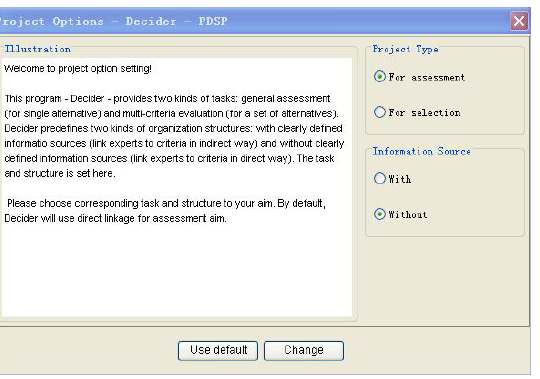
Fig.5. Setting up a PDSP evaluation problem